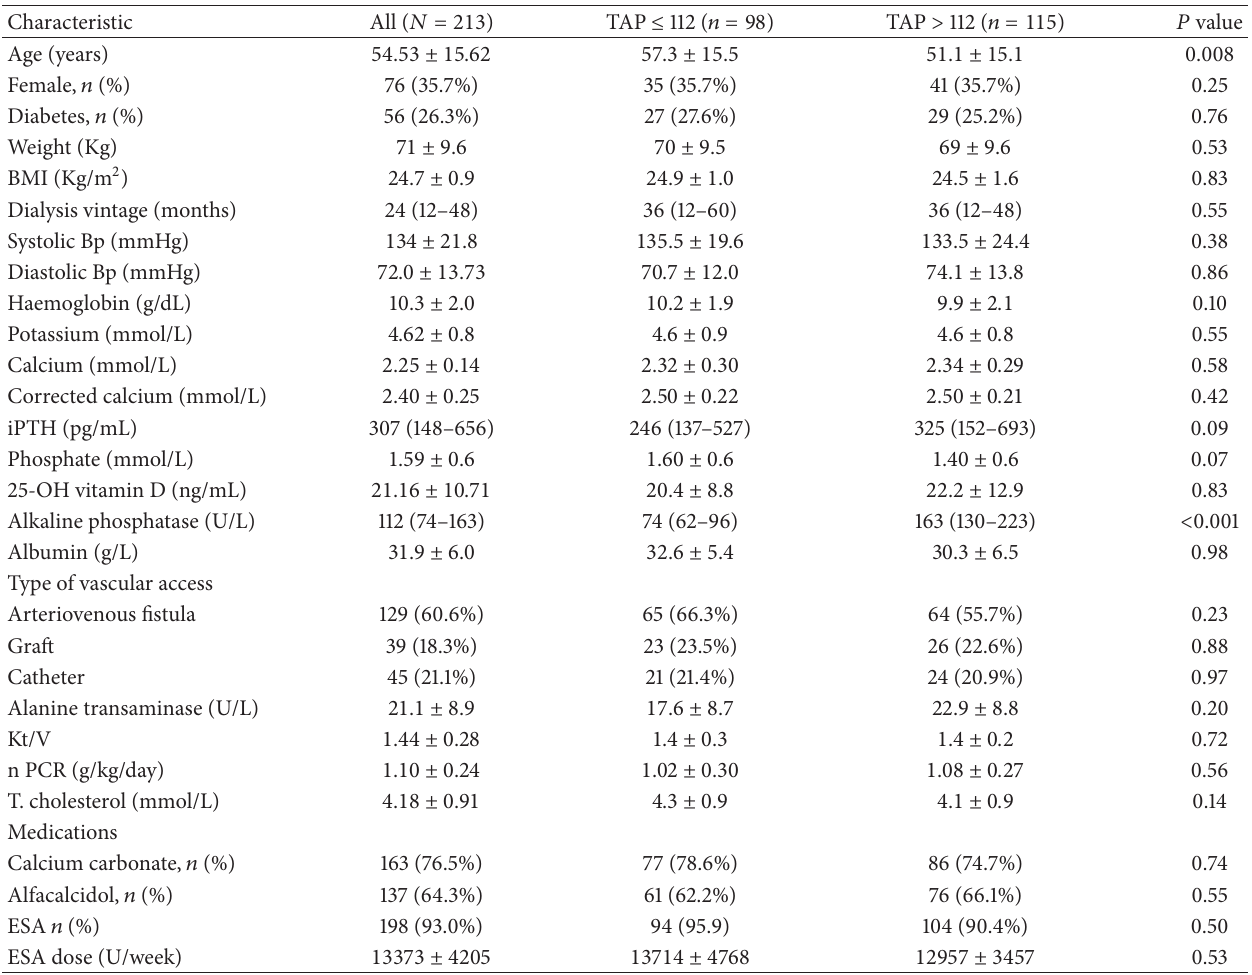
Table 1: Comparisons of baseline characteristics between patients in high TAP and low TAP